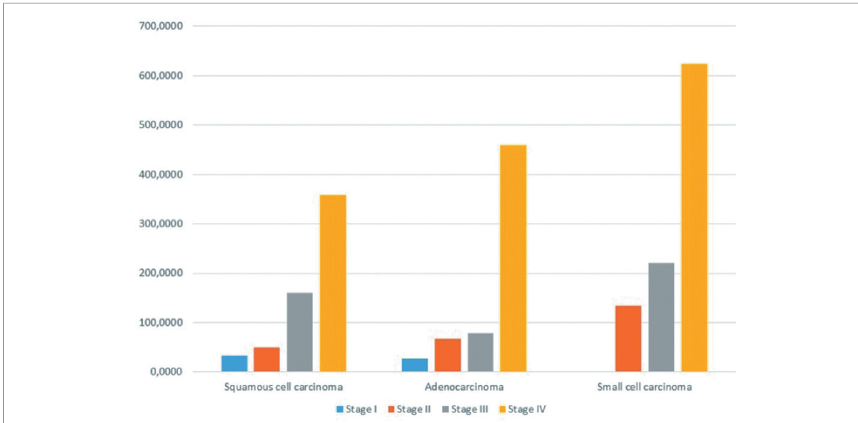
Figure2. Mean aluminum (Al) concentrations detected in the di ff erent histological subtypes of lung cancer according to